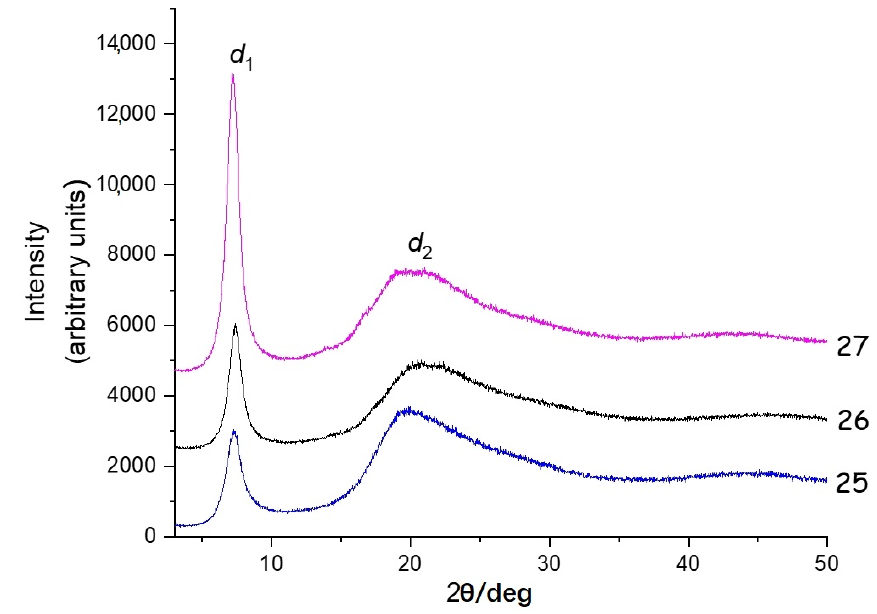
Figure 13. Diffraction data for polymers 25 – 27 .